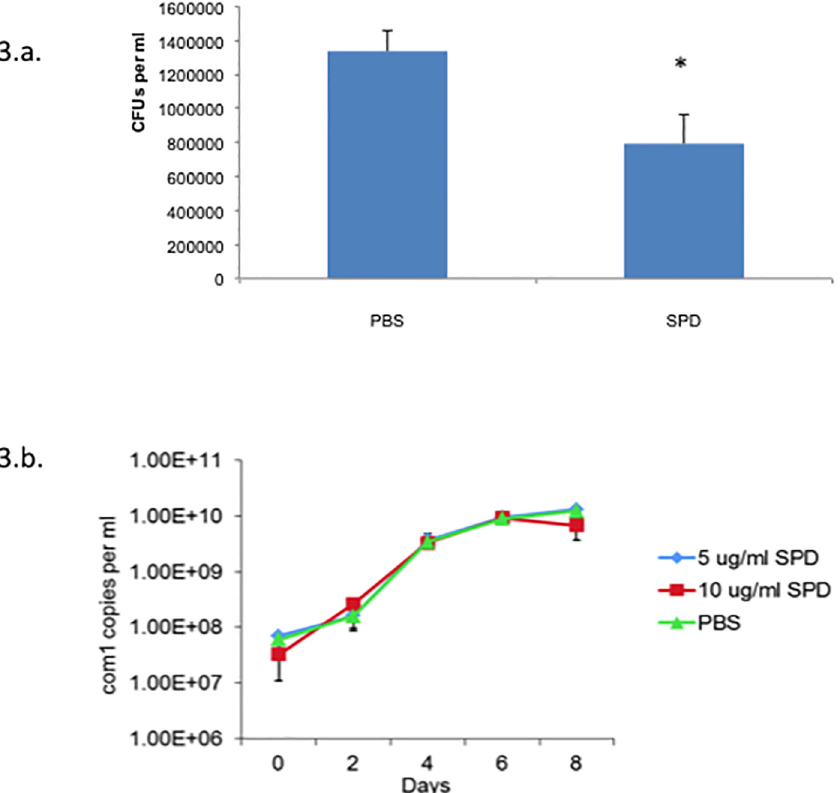
Fig 3. SP-D is not bactericidal towards C . burnetii. (A) E . coli were treated with or without SP-D for one hour at 37°C followed by viable counts on LB. Data displayed are mean ± standard error of three independent experiments. Student t-test compares SP-D to PBS treated E . coli . * p < 0.05. (B) C . burnetii were treated with 0 (triangles), 5 (squares) or 10 mg/ml (squares) SP-D overnight and transferred to ACCM-2. Every 2 days genome equivalents (GE) were calculated by real-time PCR. Data displayed are mean ± standard deviation of GE/mL, representative of three independent